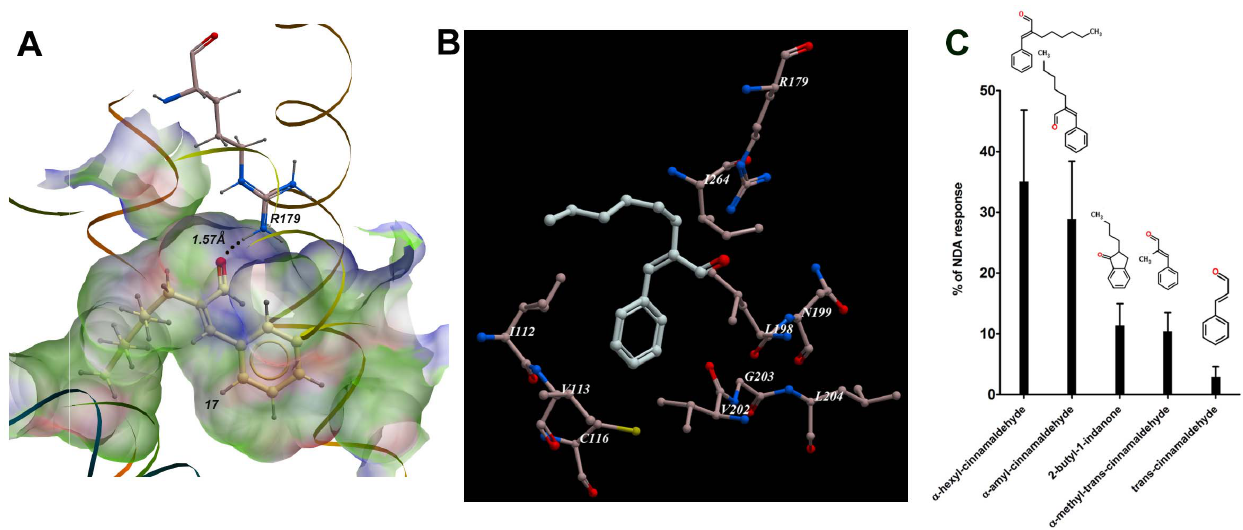
Figure 6. Agonist binding pocket and additional ligands for MOR42-3. A. a -hexyl cinnamaldehyde docked in MOR42-3. Ligand binding pocket is colored by binding property with green representing hydrophobic areas, red hydrogen bond acceptors and blue hydrogen bond donors. Hydrogen bond between carbonyl oxygen from a -hexyl cinnamaldehyde (ranked 17, Table 1 ) and guanidinuim group of arginine 179 (R179) is presented with an interatomic distance of 1.57A˚. B. Residues within 5A˚ distance from the best docking conformation of a -hexyl cinnamaldehyde. C. Structural relatives of a -hexyl cinnamaldehyde and their responses. Oocytes expressing MOR42-3, G a olf and CFTR were screened with 15 sec application of 100 m M indicated odorants. Responses were normalized to the average 100 m M NDA-evoked responses and results are presented as a mean 6 SEM, n= 5–10.